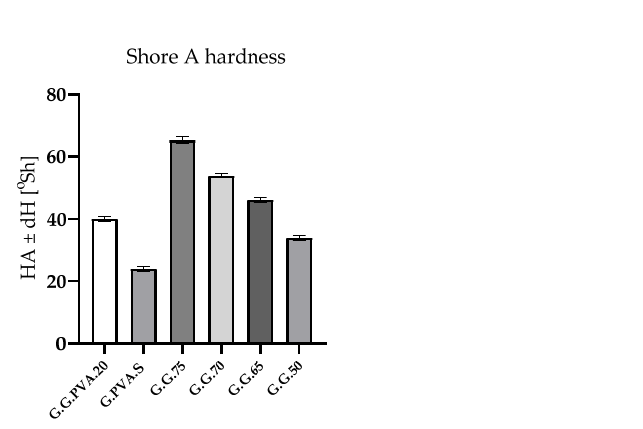
Table 4. Results of mechanical measurements.